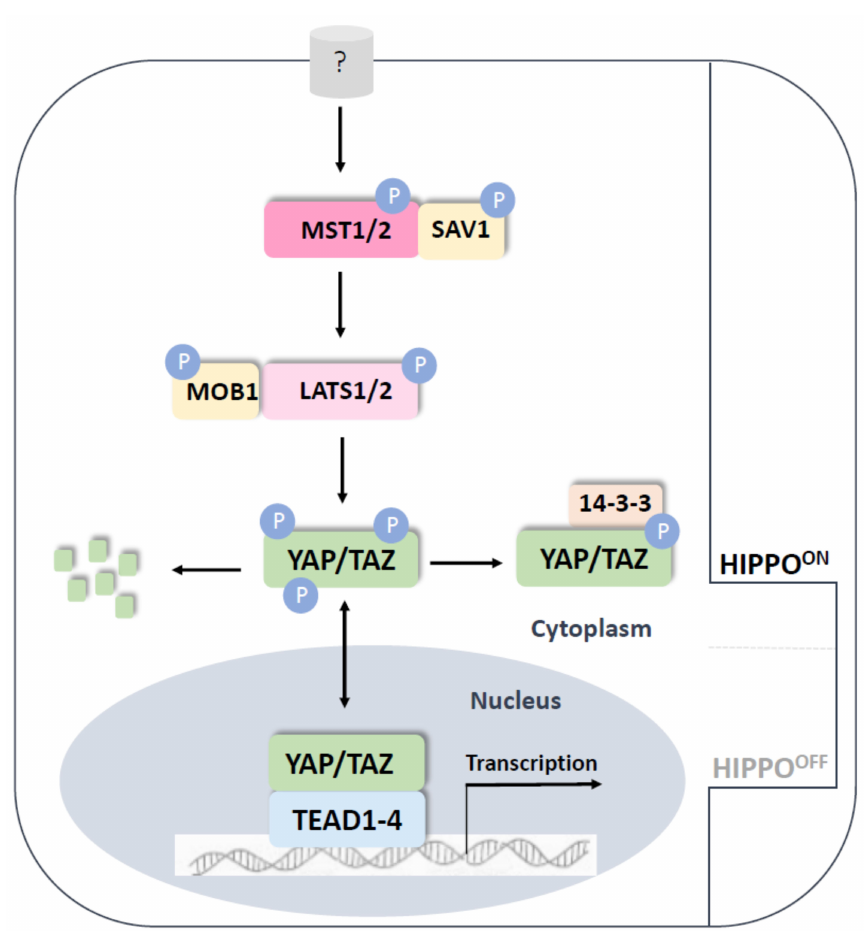
Figure 1. The Hippo pathway in mammals. The core Hippo pathway in mammals is composed of Mst1/2, Sav1 and Lats1/2 kinases. When Hippo signaling is ON, this kinase cascade is sequentially phosphorylated, eventually resulting in the phosphorylation of Yap and Taz to promote their interac- tion with the 15-3-3 protein, leading to their cytoplasmic degradation. When Hippo signaling is OFF, Yap and Taz shuttle into the nucleus and associate with other transcription factors (i.e., Tead), so as to regulate the expression of target genes involved in cell proliferation, differentiation and